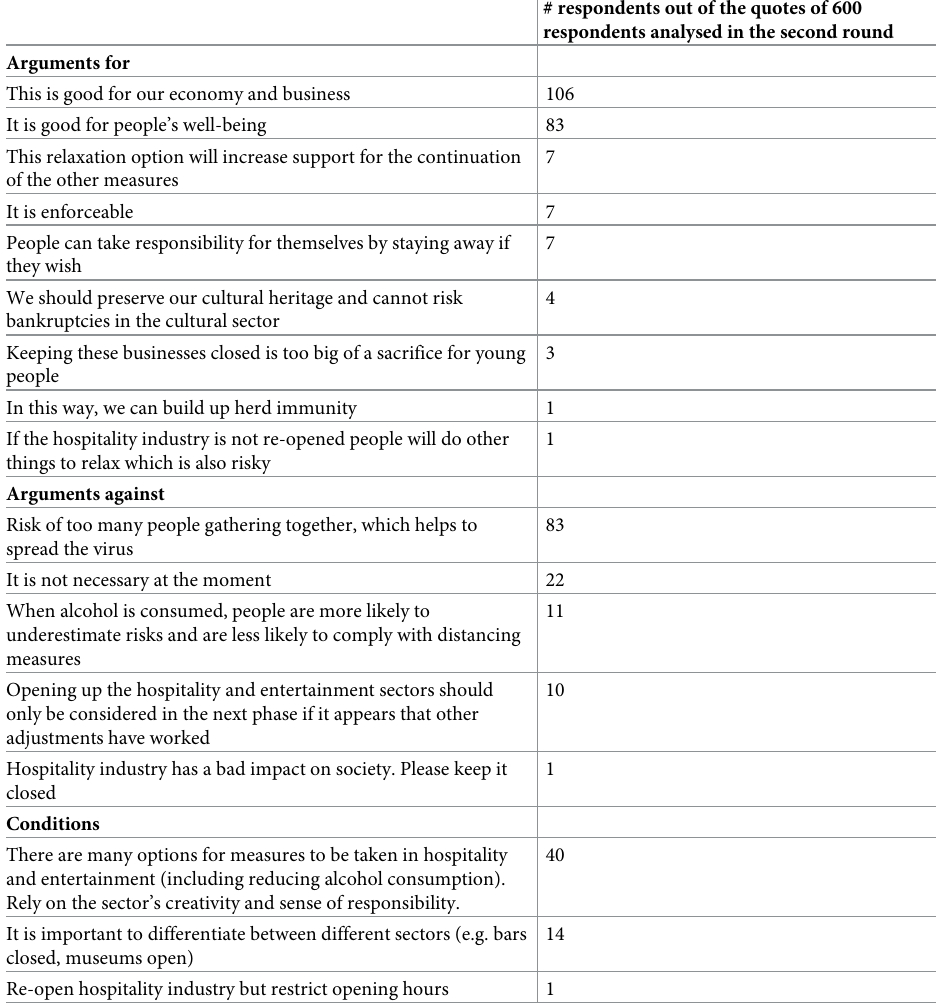
Table 12. Re-open hospitality and entertainment industry: Arguments for, arguments against and conditions.